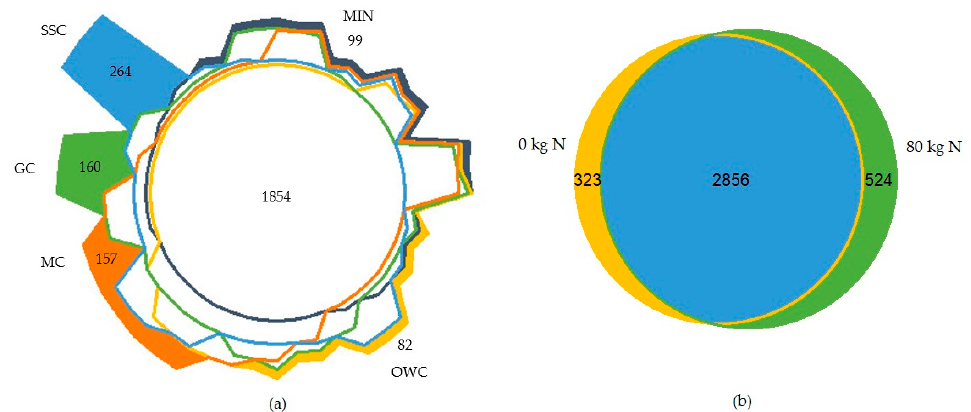
Figure 6. Venn-diagram of the bacterial/archaeal community regarding treatment factor “compost” ( a ) and regarding treatment factor “N application” ( b ). The number in the middle of the circle indicates the number of OTUs shared by all treatments. Numbers near a treatment name show the number of OTUs exclusively found in soils fertilized with this treatment. Use of colors in ( a ) was done according to Figures 1–3; and in ( b ) yellow, blue and green code for 0 kg N, core and 80 kg N, respectively.